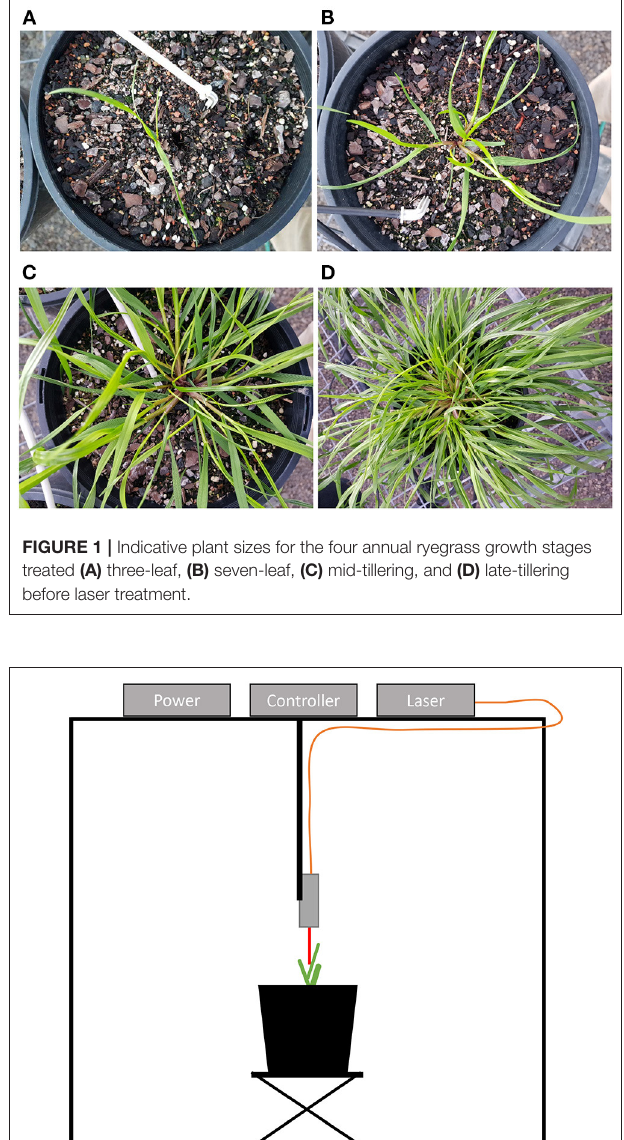
adjusting input driver voltage to the laser diode